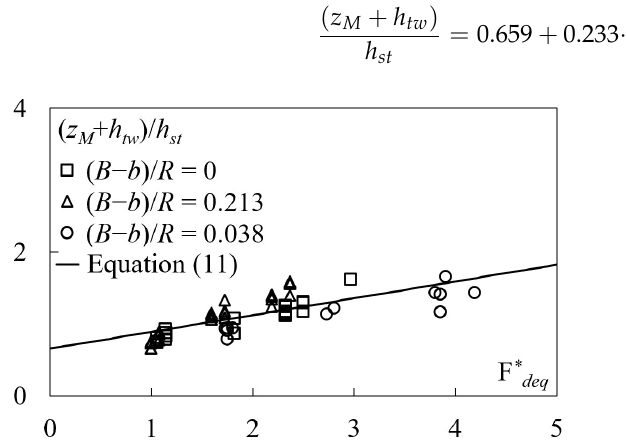
Figure 8. ( z m + h tw )/ h st vs. F* deq for wood bundles inserted in a straight channel (( B − b )/ R = 0) and the inner (( B − b )/ R = 0.213) and outer (( B − b )/ R = 0.03) banks of curved channel, along with the plot of Equation